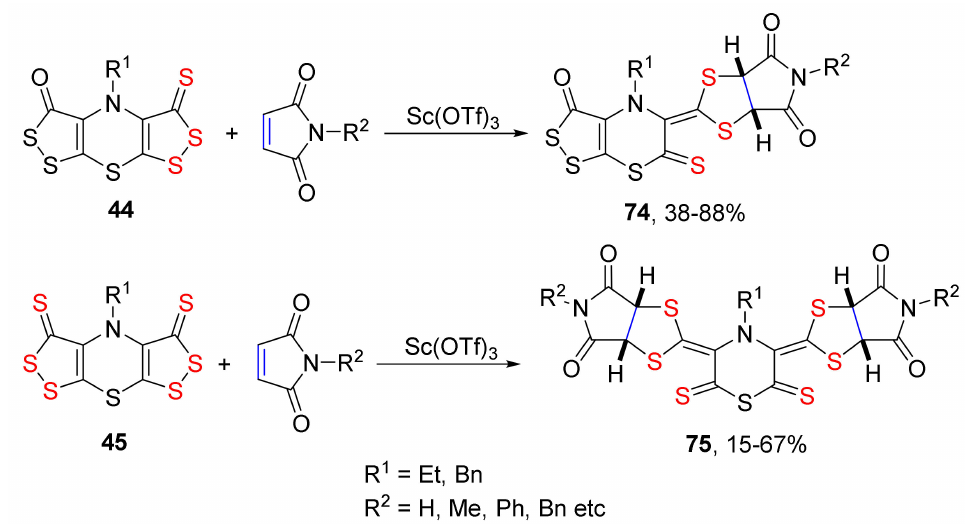
Scheme 47. Reaction of bisdithiolothiazines 44 and 45 with